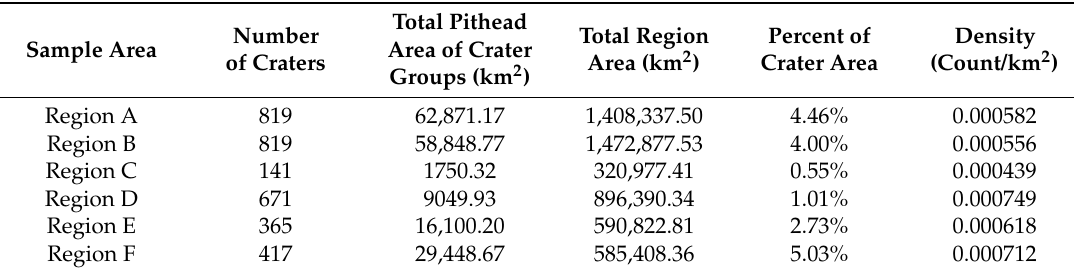
Table 10. Heterogeneity of craters in different experimental areas using the percentage of crater area and